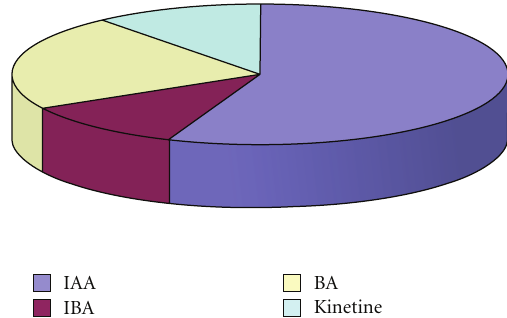
Figure 6: The relative shares of the most commonly used plant phytoregulators for Rhodiola root induction in vitro